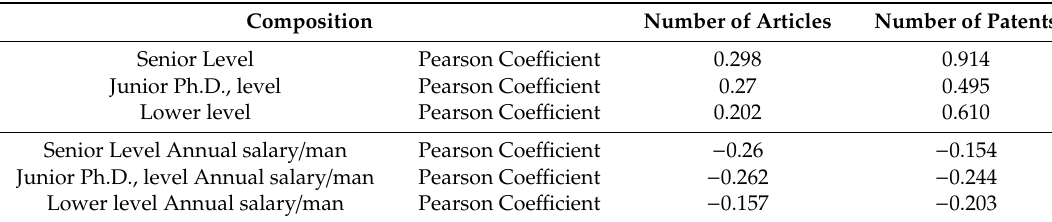
Table 3. Comparison between senior and junior researchers.